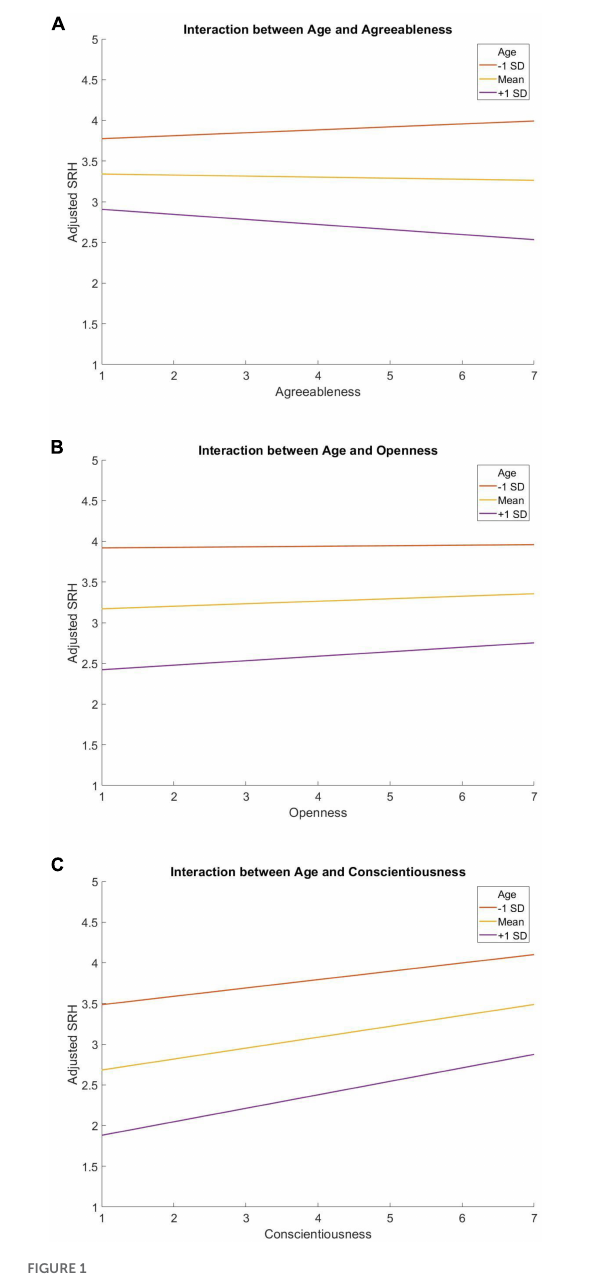
whereas Agreeableness ( b = 0.05, p < 0.001, 95% CI [0.03, 0.08]), Conscientiousness ( b = 0.12, p < 0.001, 95% CI [0.10, 0.14]) and Extraversion ( b = 0.03, p < 0.01, 95% CI [0.01, 0.05]) were positively related to SRH among young people (mean age − 1 SD). However, among mean age adults, Neuroticism ( b = − 0.16, p < 0.001, 95% CI [ − 0.17, − 0.15]) was negatively related to SRH whereas Openness ( b = 0.02, p < 0.01, 95% CI [0.01, 0.03]) and Conscientiousness ( b = 0.14, p < 0.001, 95% CI [0.13, 0.15]) were positively related